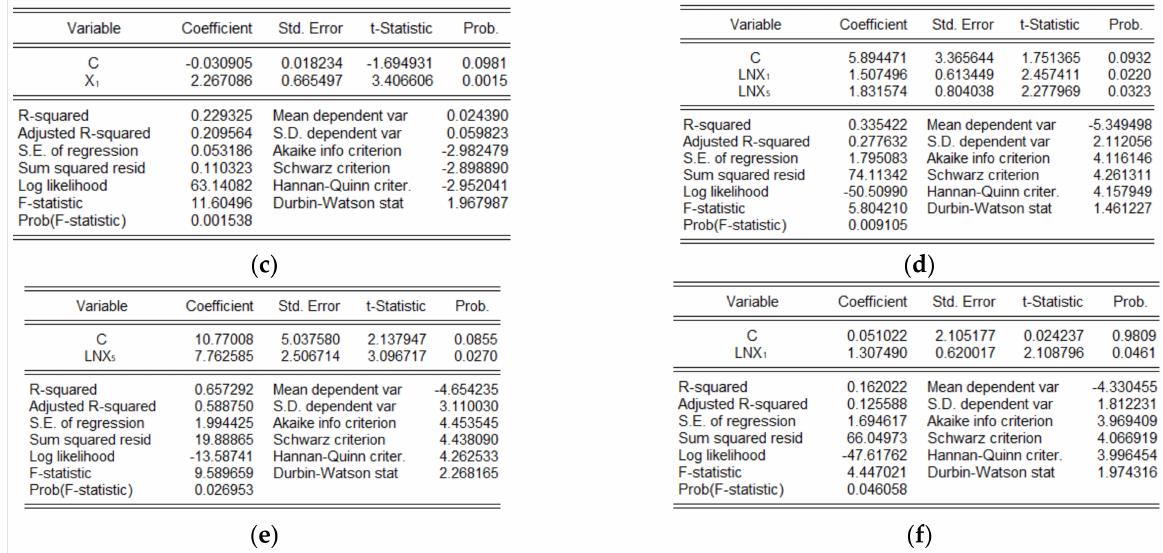
Figure 8. Model test results. ( a ) Model (7) test result; ( b ) Model (8) test result; ( c ) Model (9) test result; ( d ) Model (10) test result; ( e ) Model (11) test result; ( f ) Model (12) test